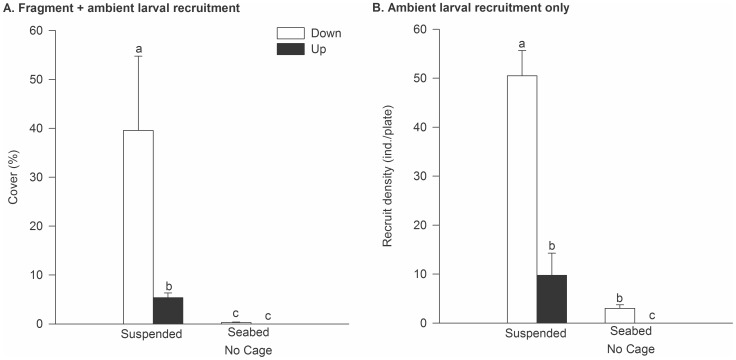
Establishment of Didemnum in suspended and seabed treatments in summer 2009 at Onahau Bay.Settlement plates were positioned in face-up and face-down orientations, with suspended plates compared to uncaged seabed plates. All plates were exposed to an ambient larval supply from a suspended pontoon 2–3 m away, for a three month experimental duration. A). Mean Didemnum cover (% cover ±1SE) on plates inoculated with Didemnum fragments. B). Mean density of Didemnum recruits (±1SE) on plates subjected only to ambient larval supply. Different letters (a,b,c) indicate significant differences as indicated by the PERMANOVA post-hoc t-test.